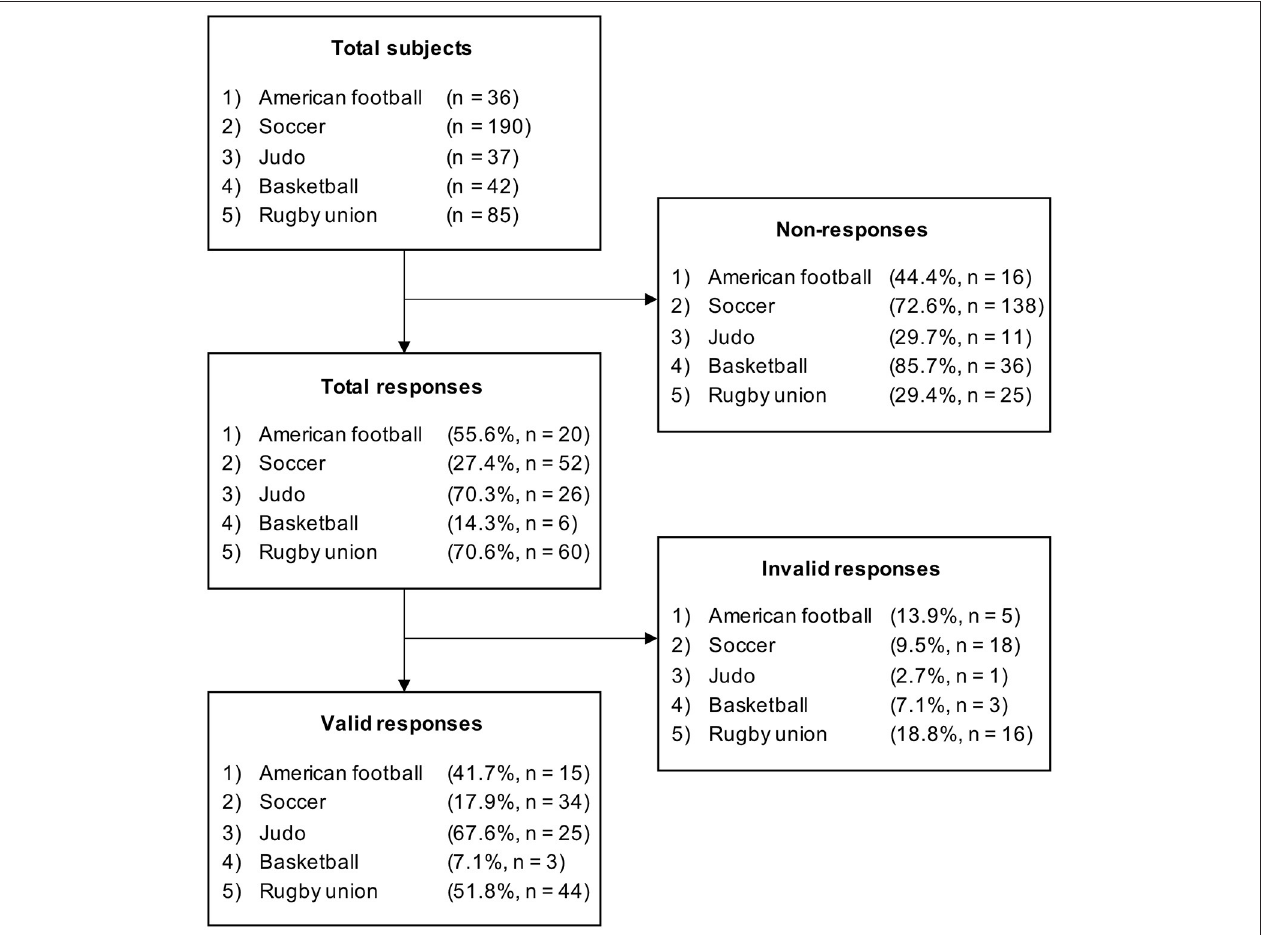
FIGURE 1 | Valid response rate of participants in each